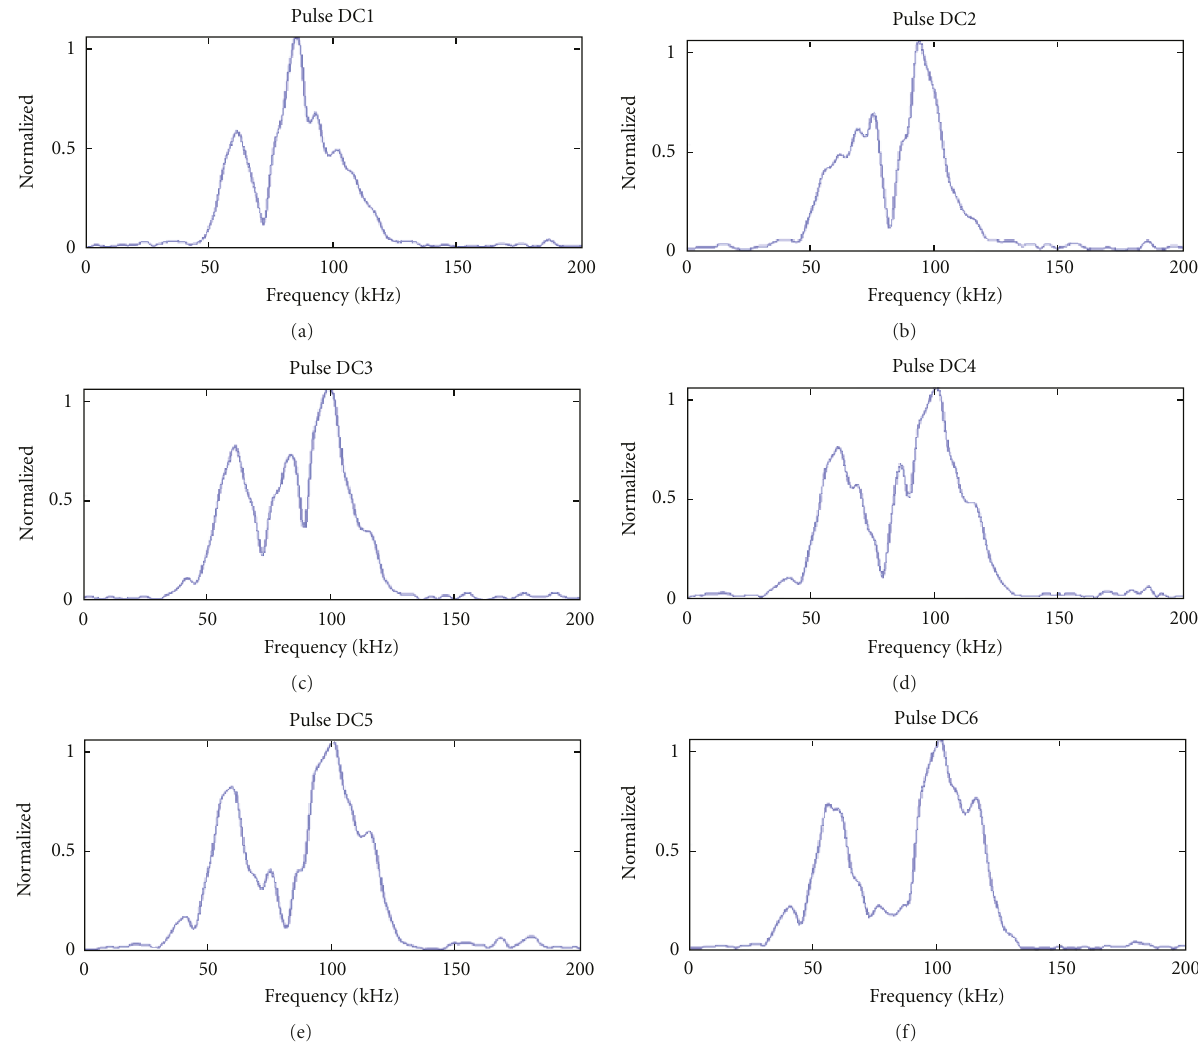
Figure 8: Record of DC4 pulse with 45 ◦ grazing angle over very coarse sand—cable echo is arrowed.